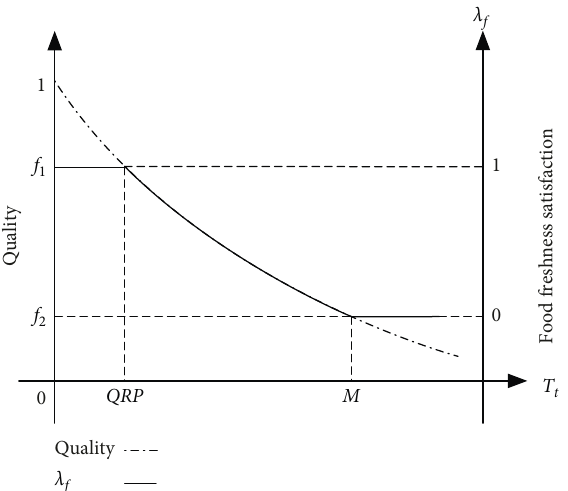
Figure 4: Quality loss and food fresh satisfaction with